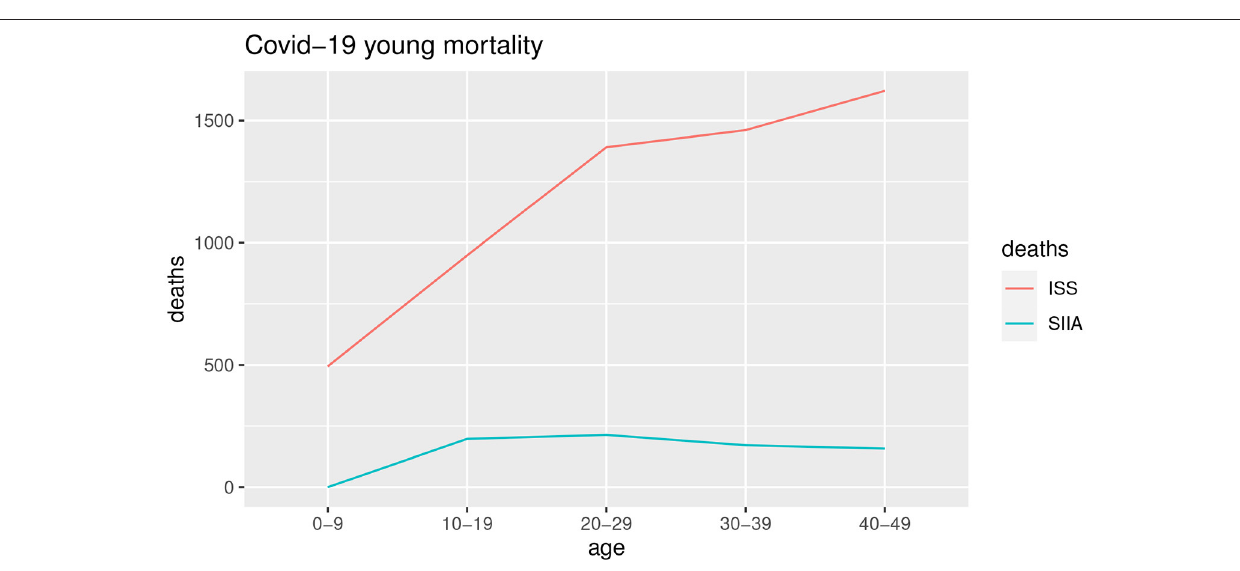
FIGURE 3 | Estimation of non-COVID-19 deaths. Young